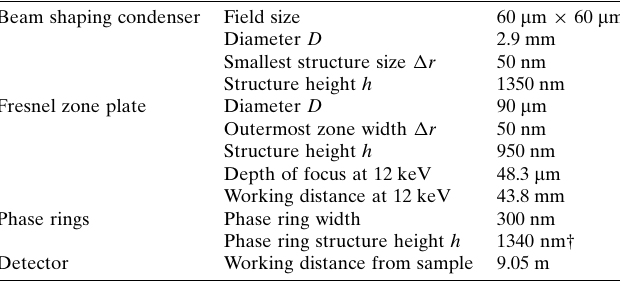
Table 3 The key parameters of the X-ray optics used for the energy bandwidth tests.